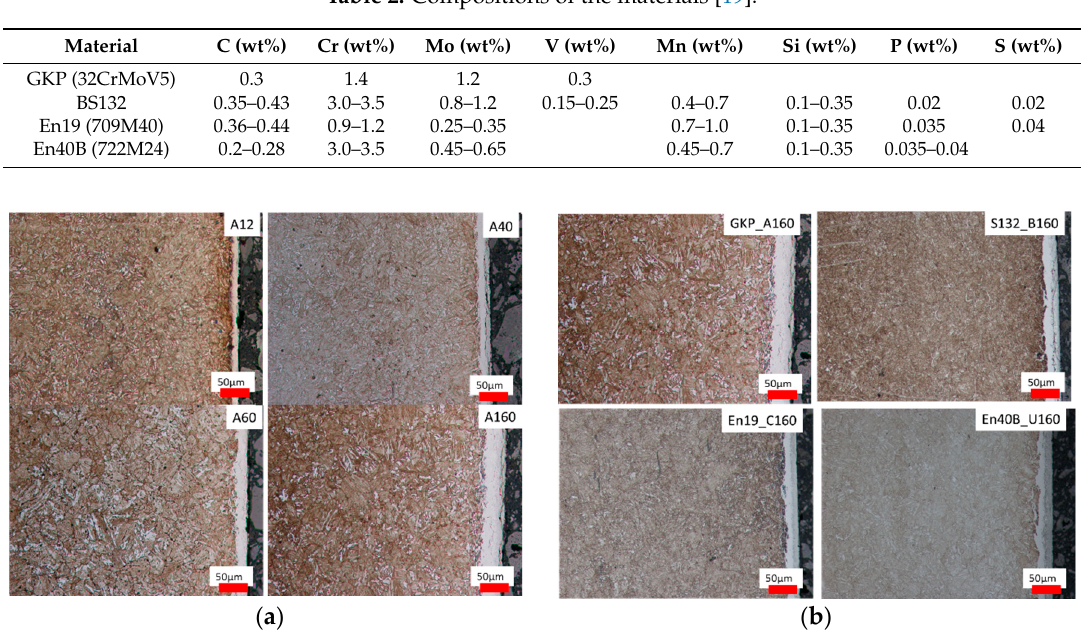
Figure 2. ( a ): Optical micrographs of GKP samples A12, A40, A60, and A180. The white layer thicknesses were 14, 20, 21, and 36 µm, respectively. ( b ): Optical micrographs with constant nitriding time of 160 h of samples GKP, S132, En19, and En40B. The white layer thicknesses were 36, 24, 21, and 32 µm, respectively.